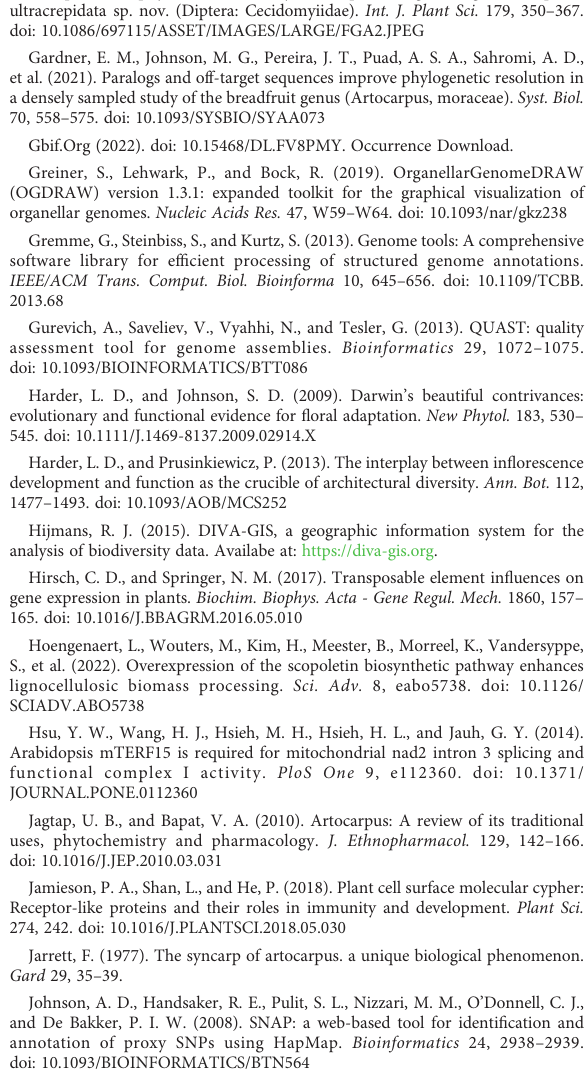
gene family, whereas the red coloured is ASMT. Gene copies of Artocarpus hirsutus are coloured in green, A. heterophyllus in blue, and A. altilis in red. SUPPLEMENTARY FIGURE 5 Approaches used to detect positive and relaxed selection in Artocarpus species. Genes identi fi ed as positively selected by all the approaches are shortlisted as positively selected